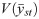
Plot of V(y¯st) against L.